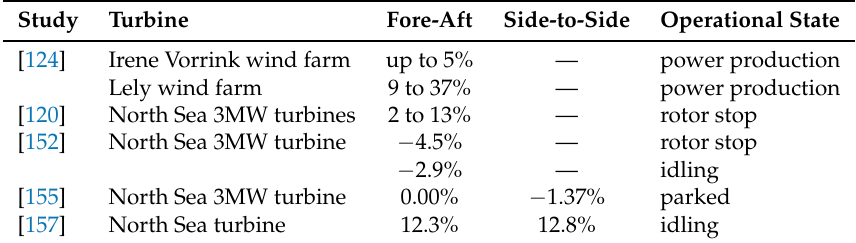
Table 2. Overview of studies presenting validations the first fore-aft and side-to-side natural frequencies of wind turbines, indicating the underestimation of the modelled frequencies compared to the identified